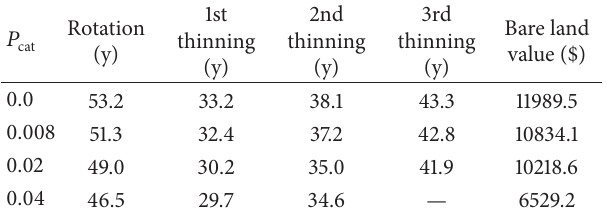
Table 4: Effect of the increasing probability of a catastrophe ( 𝑃 on the economic thinning schedule of Dulaer 76. The discount rate is 3.5%.